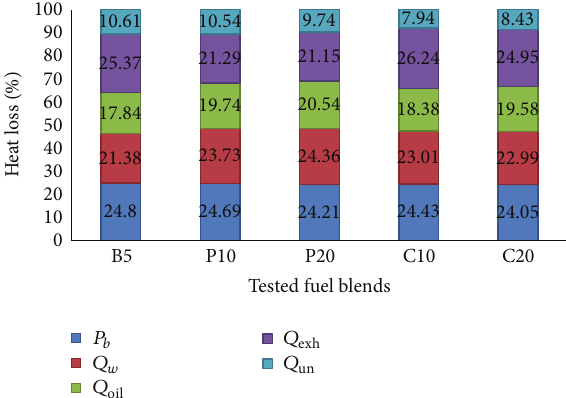
Figure 13: Engine energy balance at 2000 RPM and 100% load.